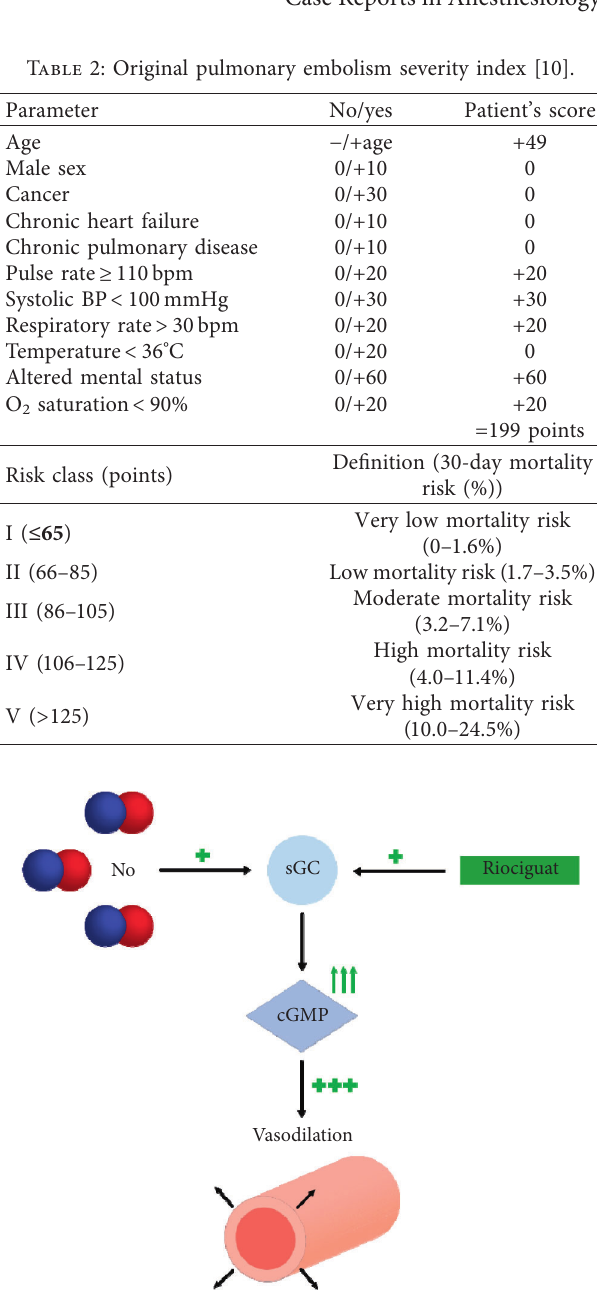
Figure 4: The figure demonstrates a simplified NO-sGC-cGMP pathway. Compromised endogenous NO synthesis and signaling is involved in the pathogenesis of pulmonary hypertension [8, 9]. Both NO and riociguat stimulate sGC which increases the levels of cGMP. This relaxes smooth muscle cells, induces vasodilation, and reduces PVR. Abbreviations: NO: nitric oxide, sGC: soluble gua- nylate cyclase, cGMP: cyclic guanosine monophosphate, PVR: pulmonary vascular resistance.